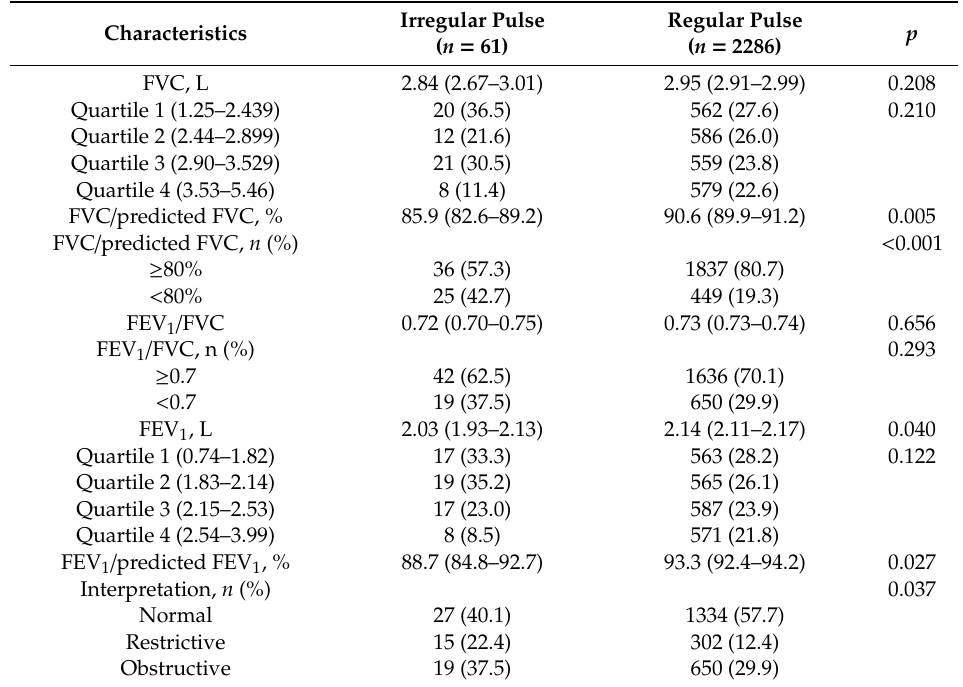
Table 3. Spirometry